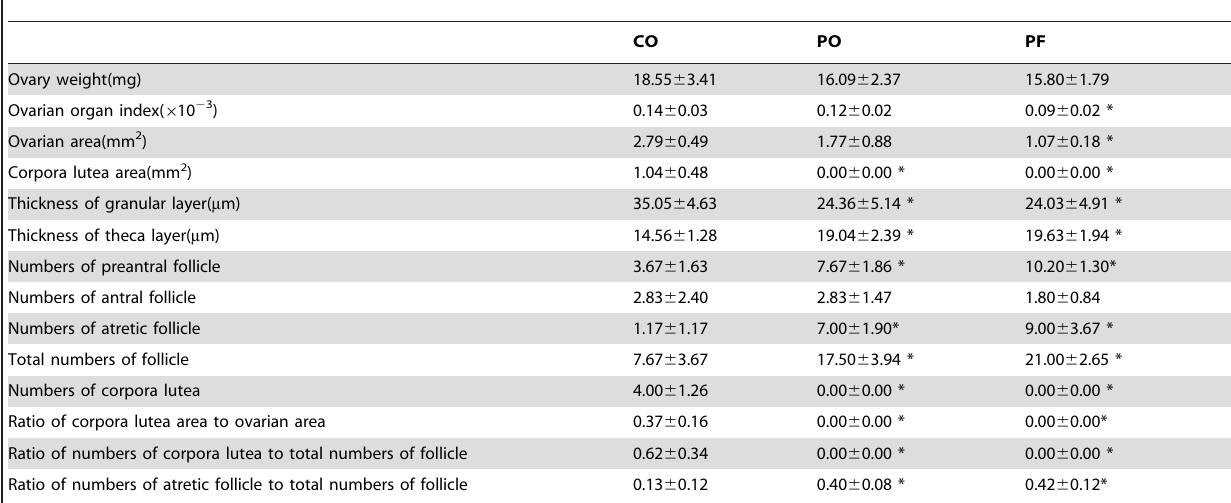
Table 2. Changes of ovarian morphological parameters in PF.